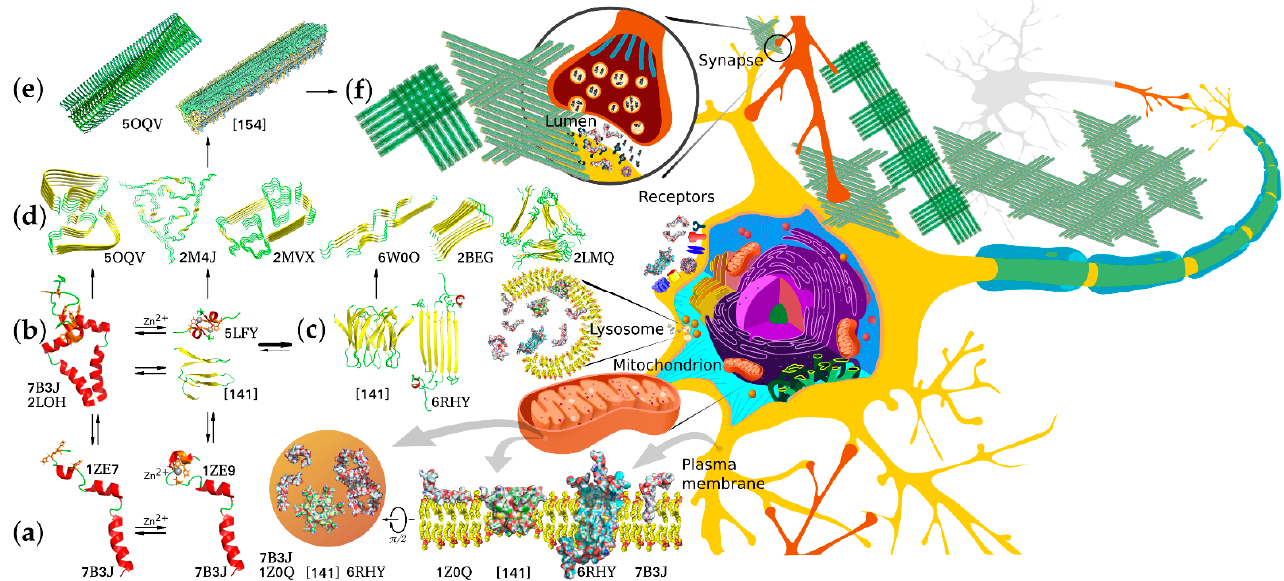
Figure 2. Structural diversity of A β aggregation states, aggregation pathways, and examples of biologically relevant interaction targets. Corresponding PDB accession numbers are indicated alongside the diagrams. ( a ) Free and cation-bound monomeric A β peptides (the structure combined from solution NMR structures of folded A β 1–16 metal-binding domain and A β 17–42 fragment) are capable of dimerizing via different dimerization interfaces situated in the TM, JM, and metal-binding site regions using protein–protein and protein–cation interactions involving α -helix, β -strand, and random coil structures. ( b ) Alternative dimers nucleate aggregation into neurotoxic intermediate oligomers that can interact with different target proteins and lipid membranes of neurons. ( c ) Two known configurations of predominantly β -structured minor oligomers capable of forming pore-like proteolipid aggregates and prone to further aggregation into protofibrillar structures. ( d ) Diverse structural motifs that can constitute amyloid fibril core structures capable of further aggregating into filaments and fibrillary deposits. ( e ) Two possible alternative fibril structures with biaxial and triaxial symmetry depositing to form macroscopic aggregates ( f ) constituting senile plaques, a known hallmark of AD. All the diverse A β aggregation forms appear to interact with multiple alternative targets, thus mediating normal physiological functions or pathological processes. The interactions are known to occur in multiple morphological units and organelles, including plasma and synaptic membranes and inter- and intracellular